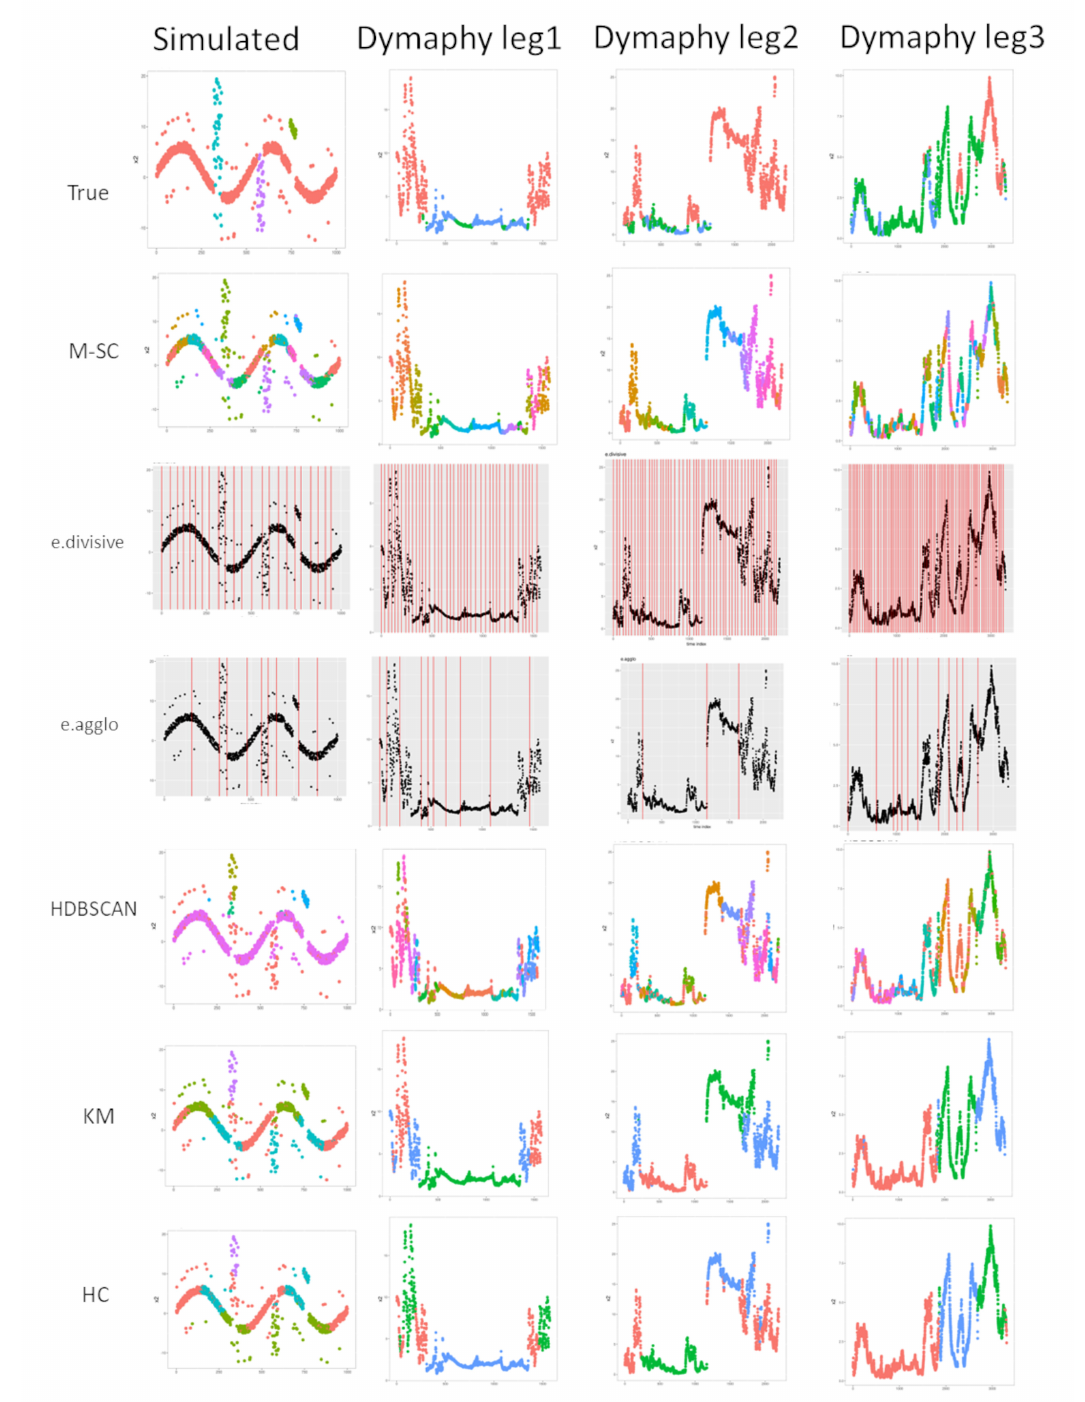
Figure 3. Color-labelling for the most efficient clustering methods on time series (True: ground-truth labels, M-SC Multivel Spectral Clustering, HDBSCAN: Hierarchical density-based spatial clustering, KM: Kmeans, HC: Hierarchical